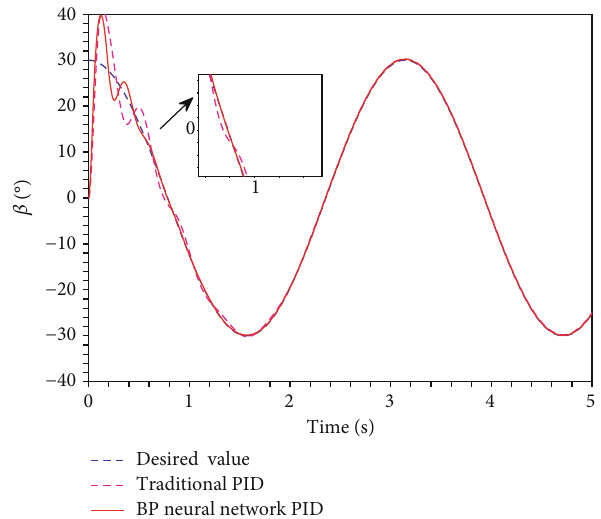
Figure 17: The trajectory tracking comparison about Euler angle β .